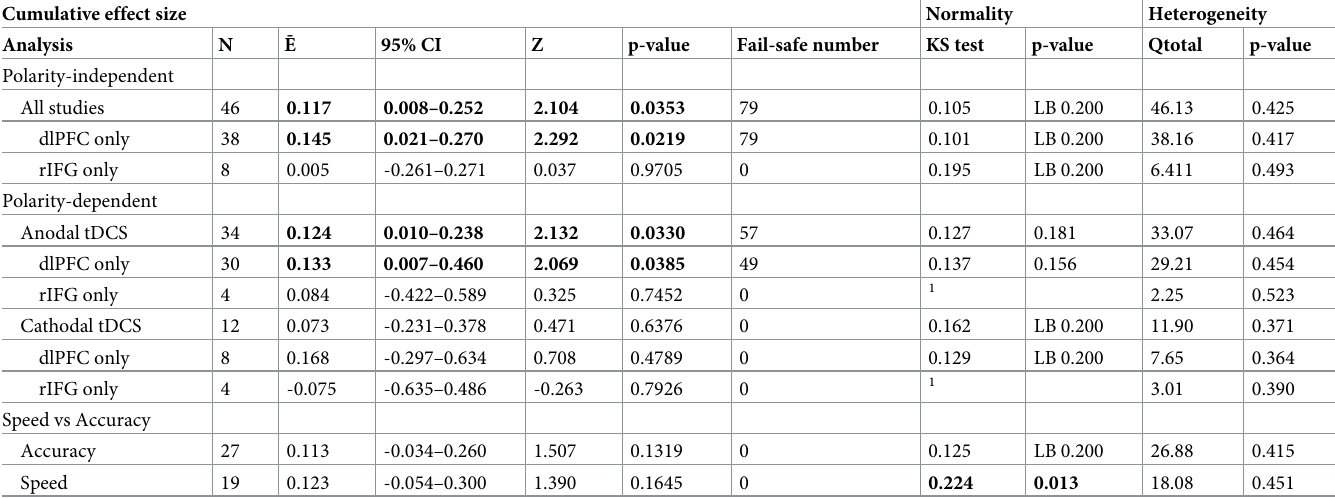
Table 3. Meta-analysis results for the effects of tDCS on inhibitory control in ADHD patients.